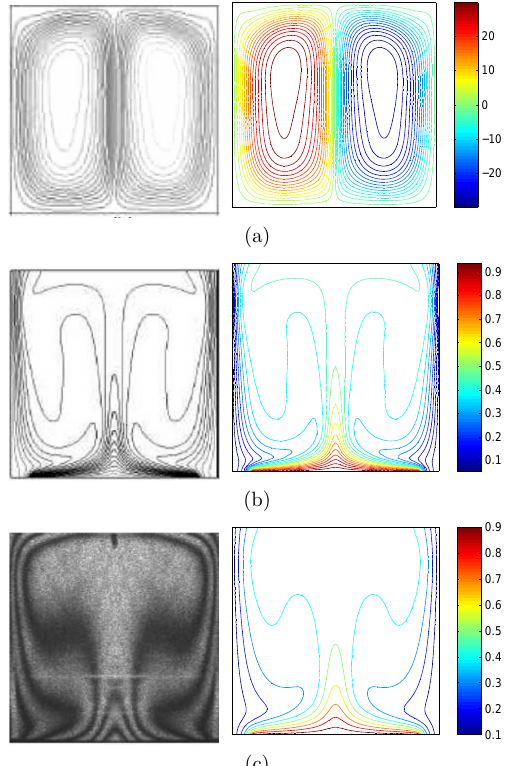
Figure 2. (left) Numerical results from Calcagni et al. [35] and (right) the present study for ( a ) streamlines at Ra = 10 6 and H = 0.4; ( b ) isotherms at Ra = 10 5 and H = 0.8; and ( c ) (left) experimental results [35] and (right) present numerical results for isotherms at Ra = 1.836 × 10 5 and H = 0.8 for the case where φ = 0 and D =